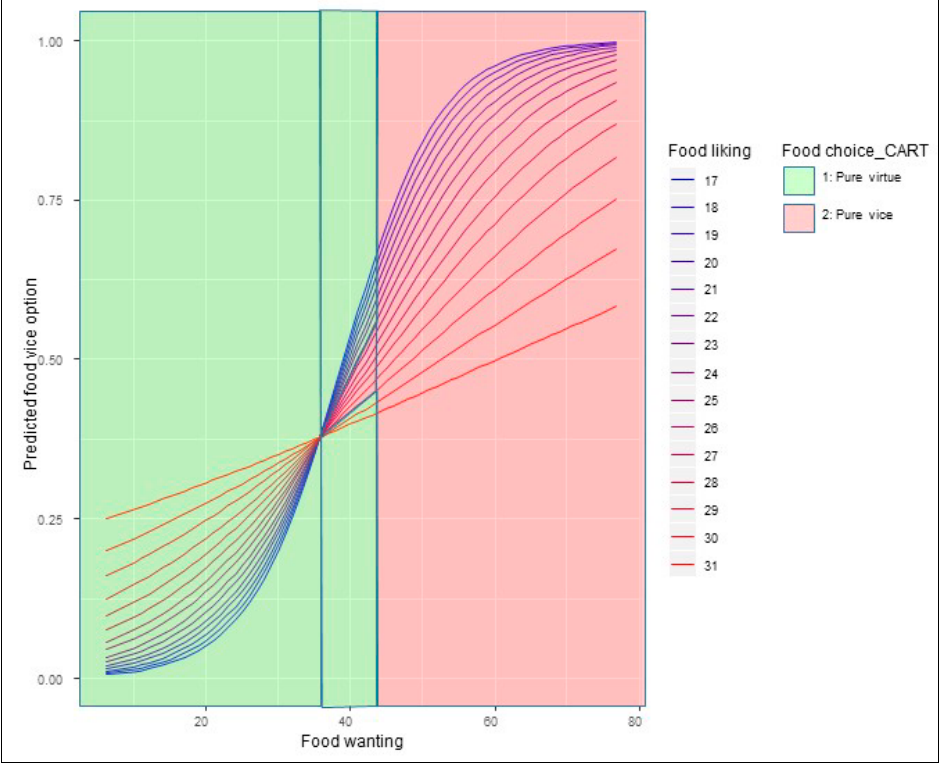
Figure 11. Marginal effects and CART of the interaction term (Food liking*Food wanting). Five-option set.